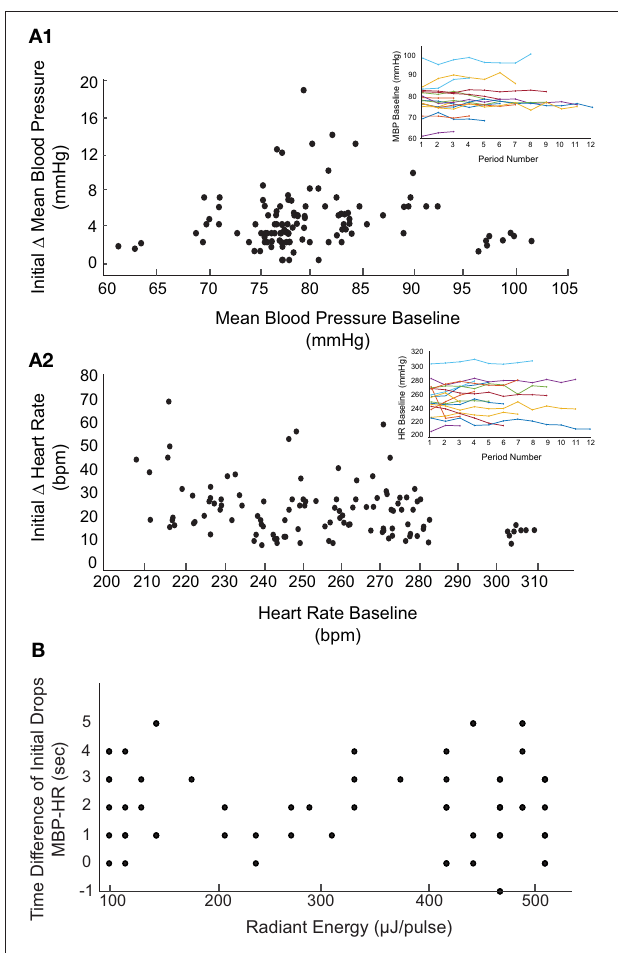
FIGURE 5 | Relationship between baseline and magnitude of changes in BP and HR. The initial decreases in MBP (A1) and HR (A2) in response to the 113 IR stimulation events (17 rats) are shown with respect to the averaged baseline MBP and HR prior to each stimulation. Overall, MBP and HR remained steady throughout the experiment (insets show the MBP and HR baselines over multiple IR periods for the 17 rats). (B) The relationship between latency of responses to IR at varying radiant energies ( µ J/pulse) is shown. Latency of responses were calculated by taking the difference in time (seconds) of the initial decrease in MBP from initial decrease in